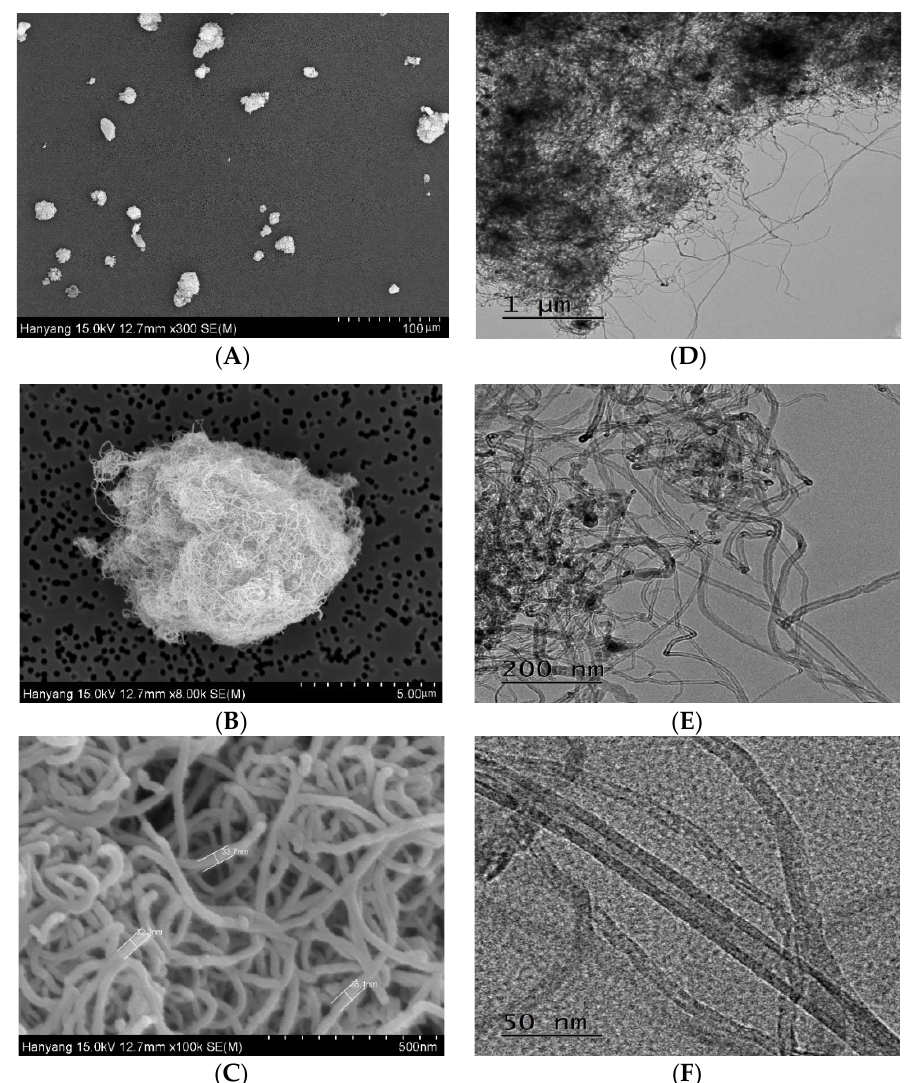
Figure 3. ( A – C ) FE-SEM analysis; ( A ) CNF agglomerates (scale: 100 μ m); ( B ) high magnification of CNF mono-agglomerate (scale: 200 μ m) ( C ) mono-fiber thickness (32~35 nm): ( D – F ) FE-TEM anal- ysis; ( D ) agglomerated state of CNFs (scale: 1 μ m); ( E ) fibrous state of CNFs (scale: 200 nm); ( F ) high magnification of ( E ) (scale: 50 nm).